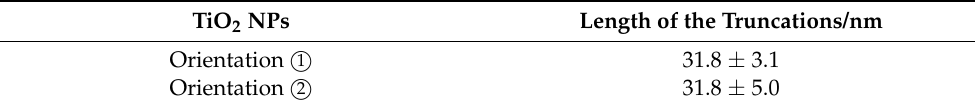
Table 6. Length of the NP truncations (at one side only) along their major axis according to the TiO 2 NPs